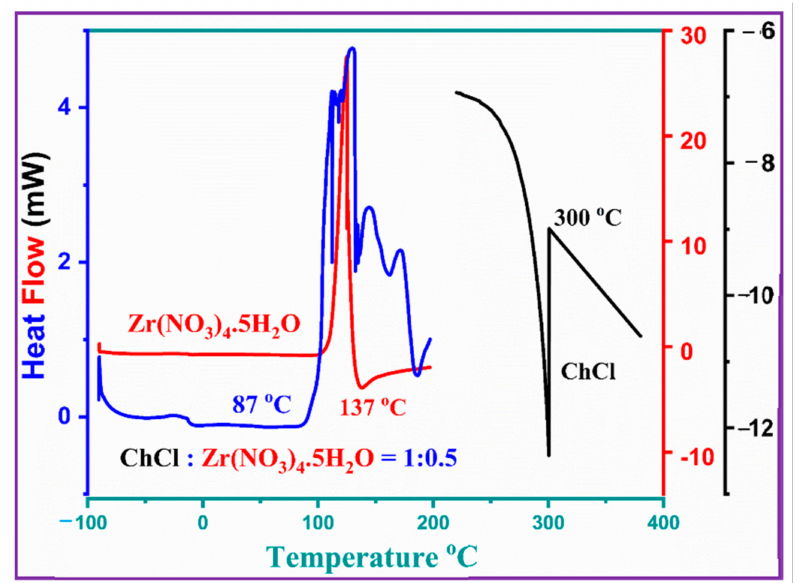
Figure 2. The DSC curve of the hydrogen bond acceptor (ChCl), a hydrogen bond donor (Zr(NO 3 ) 4 · 5H 2 O and a eutectic mixture with the molar ratio of